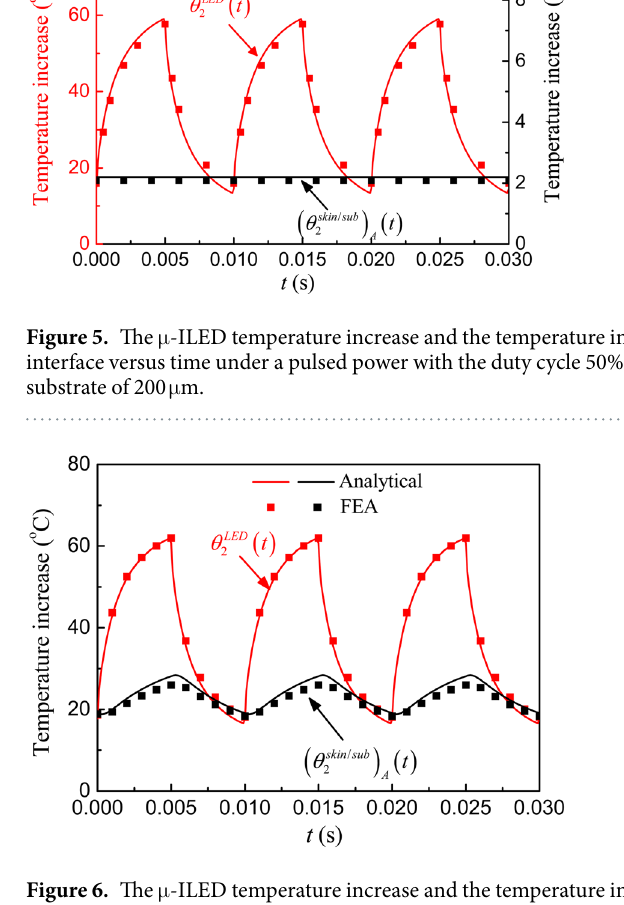
Figure 6. The μ -ILED temperature increase and the temperature increase at point A on the skin/substrate interface versus time under a pulsed power with the duty cycle 50% and period 10 ms for the thickness of substrate of 20 μ m.